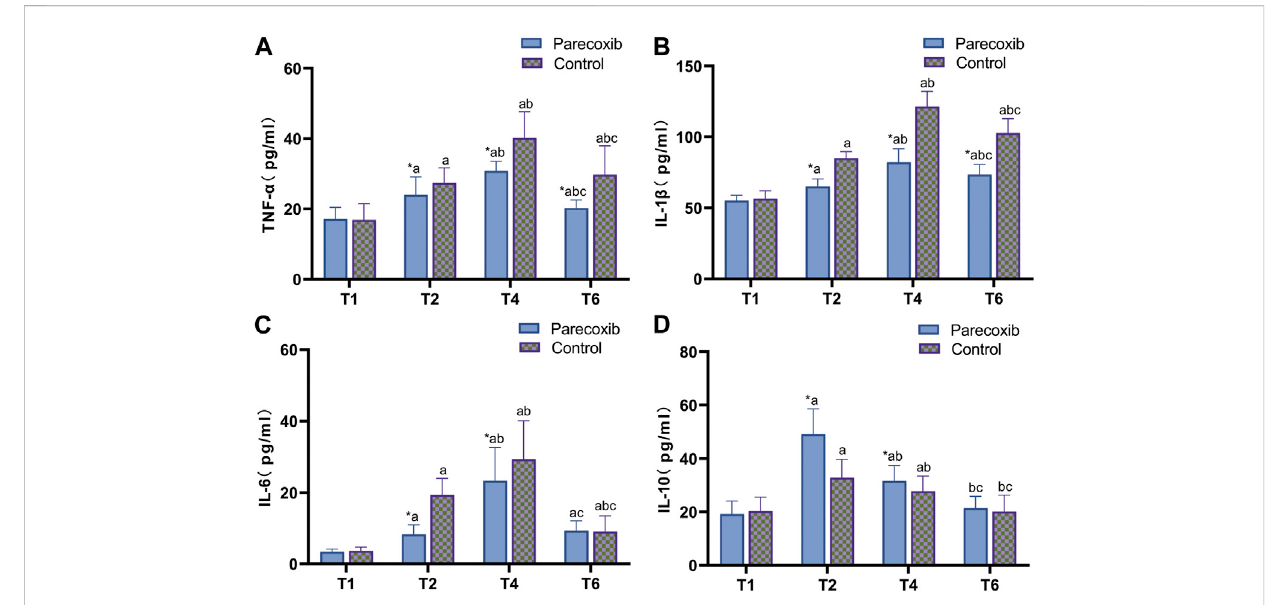
FIGURE 1 Changes of TNF- α (A) , IL-1 β (B) , IL-6 (C) and IL-10 (D) at different time